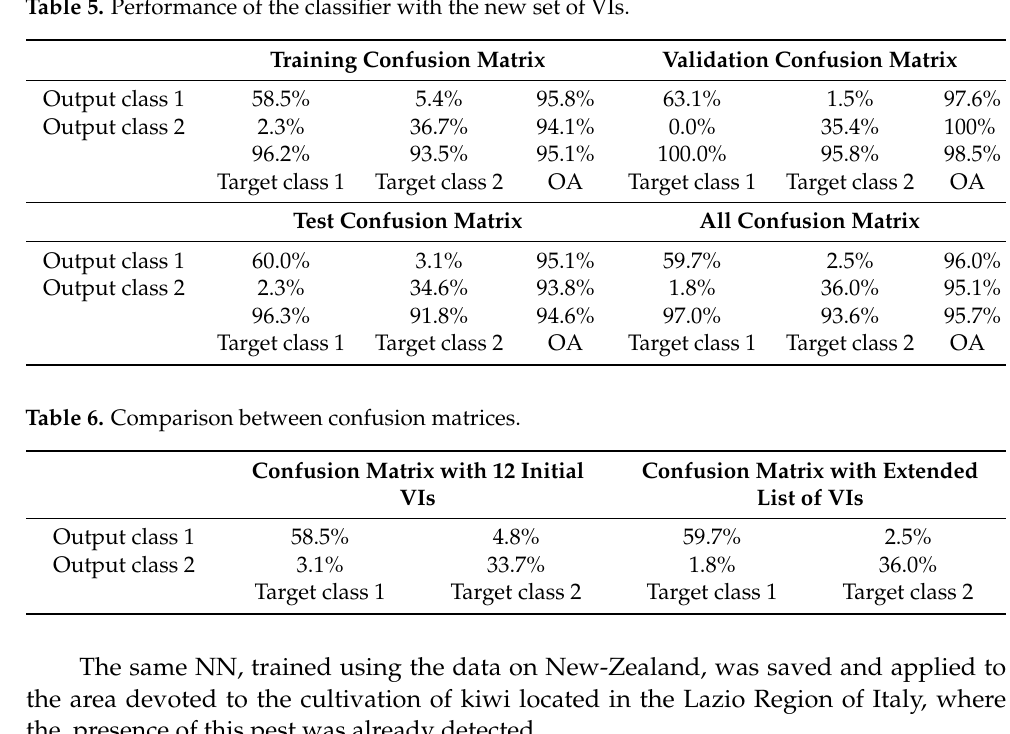
Table 5. Performance of the classifier with the new set of VIs.